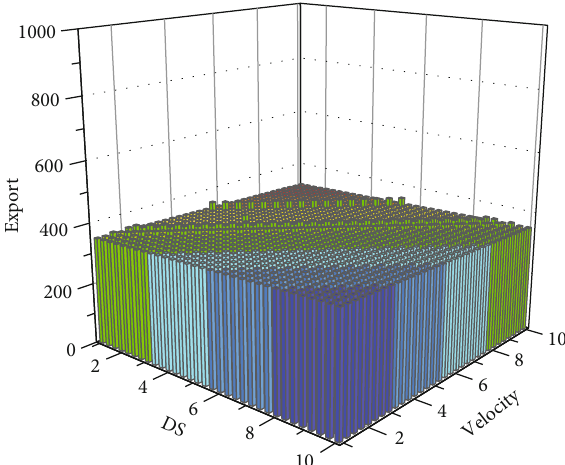
Figure 6: Iterative variation diagram of the network model after removing global features.